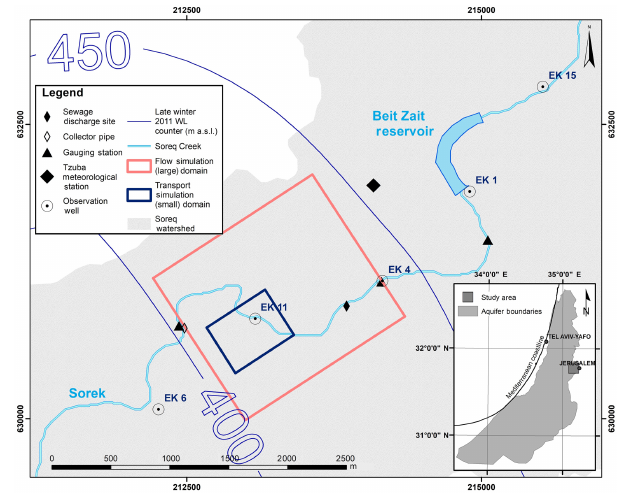
Figure 1. The upper Sorek Basin monitoring sites and flow and transport simulation domains (following Dvory et al., 2018a; aquifer boundaries from Dafny et al.,